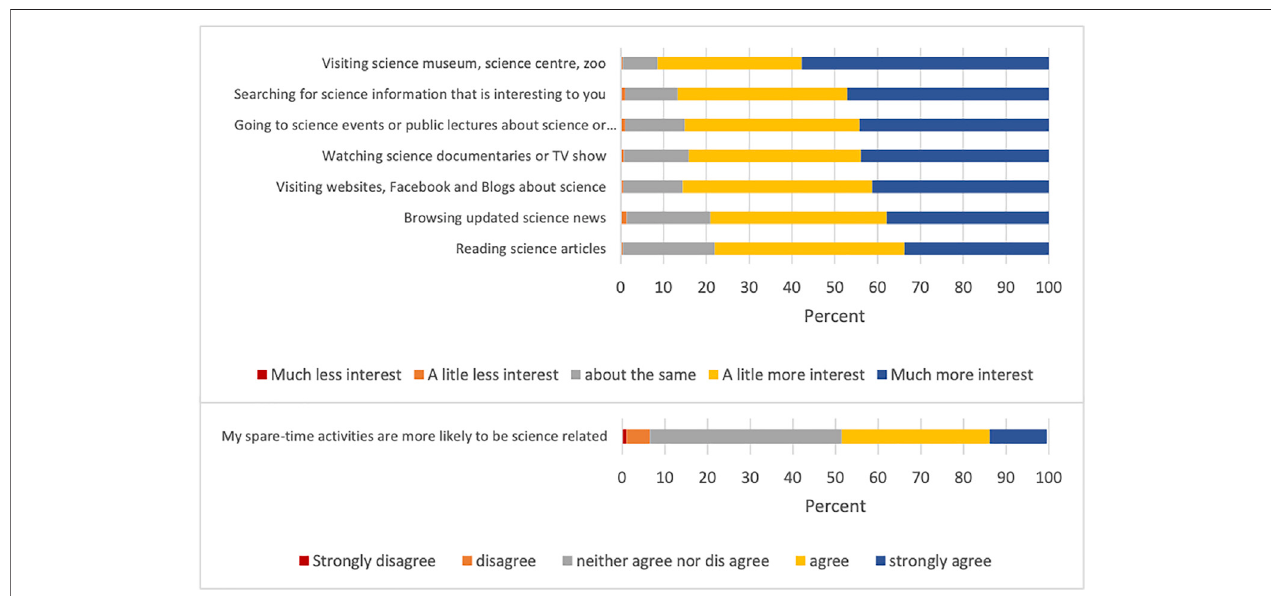
FIGURE 5 | Alumni presenters ’ views on impact of presenting on their interest in lifelong learning activities in